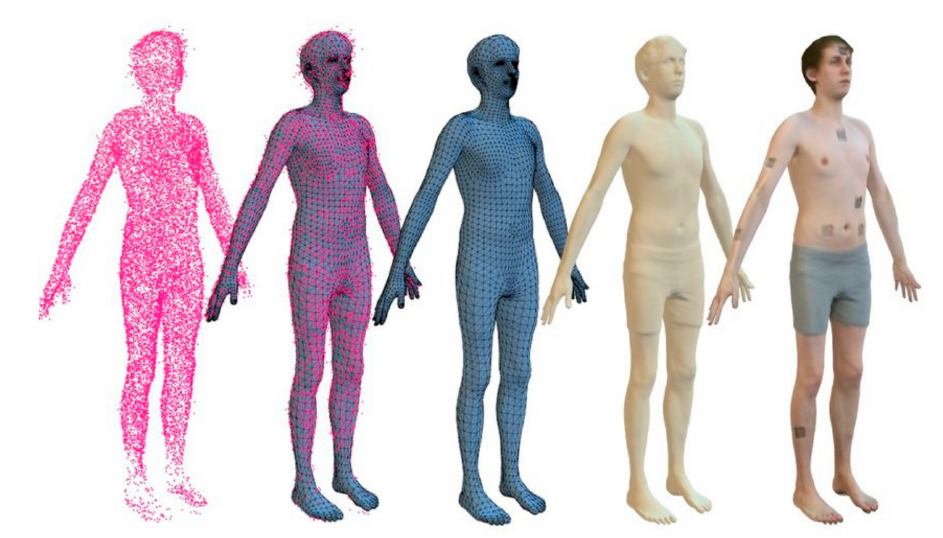
Figure 2. Steps for mesh